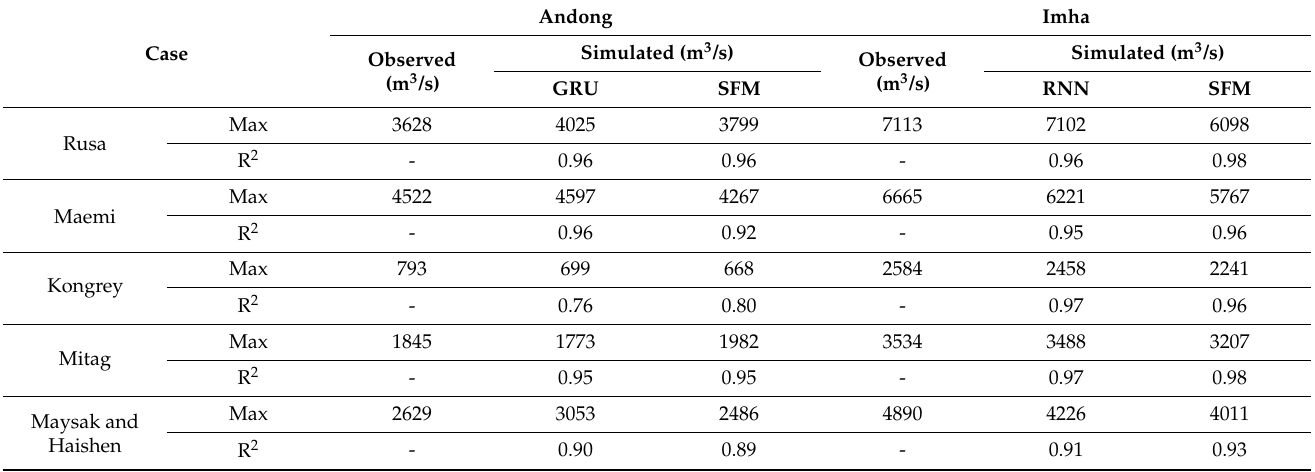
Table 12. Predicted inflow by optimal deep learning model and the SFM in typhoon